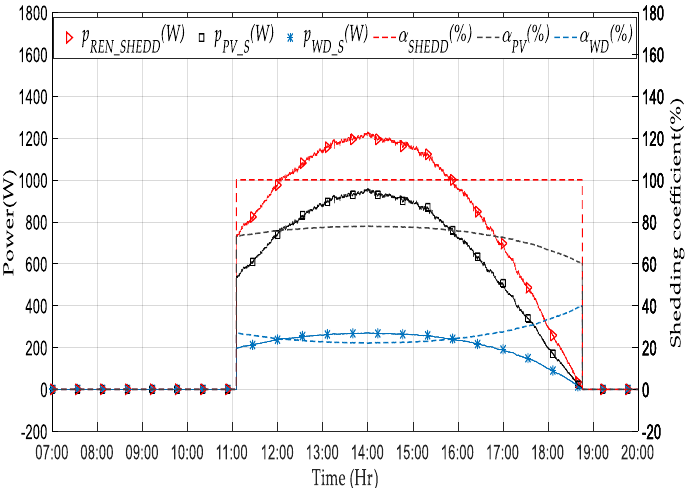
Energies 2022 , 15 , x FOR PEER REVIEW 17 of 27 Figure 6. Power flow curves without optimization by applying the  coefficient. Figure 6. Power flow curves without optimization by applying the α coefficient.